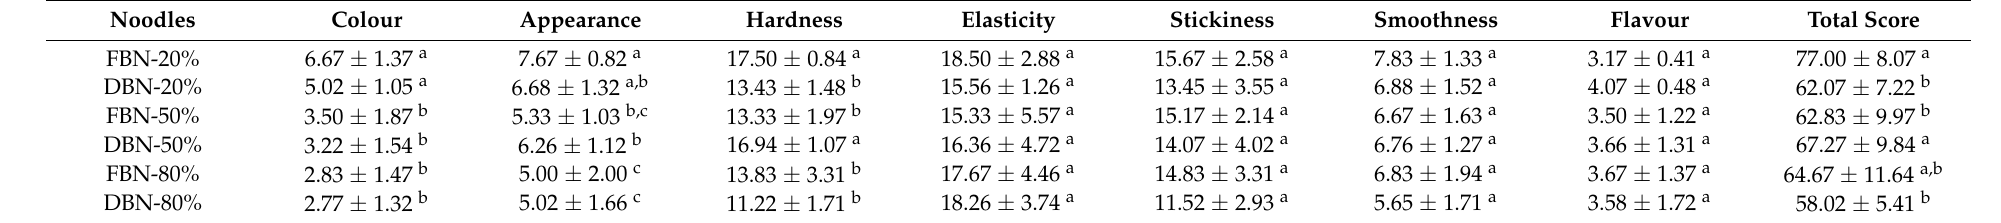
Table 3. Sensory properties of cooked FBN and